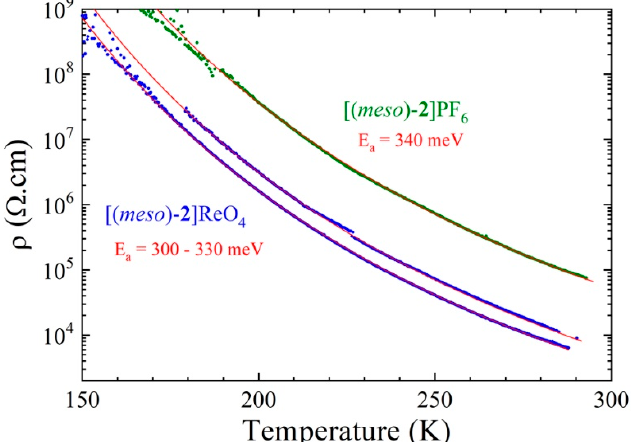
interactions. Red dotted lines (3.34–3.41 Å), green dotted lines (3.49 Å), blue dotted lines (3.79 Å), magenta lines (3.48 Å), brown lines (3.65 Å); ( b ) Packing diagram in the bc plane showing the donors-anions’ segregation.